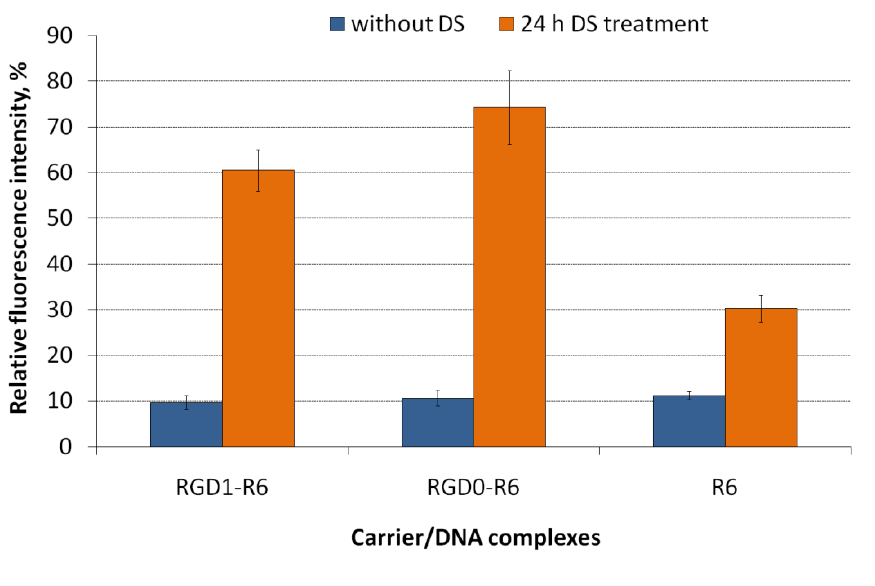
Figure 4. DNA release ( a ) after DTT treatment of DNA-complexes with RGD1-R6, RGD0-R6 and R6 carriers and ( b ) after relaxation of DNA complexes with RGD1-R6, RGD0-R6 and R6 carriers after 24 h of DS treatment in three-fold charge excess. Values are the mean ± SD of the mean of triplicates. Interaction of negatively-charged GAGs (heparan sulfate, chondroitin sulfate B and C etc.) with polyplexes may influence on DNA transfer. GAGs are found both within